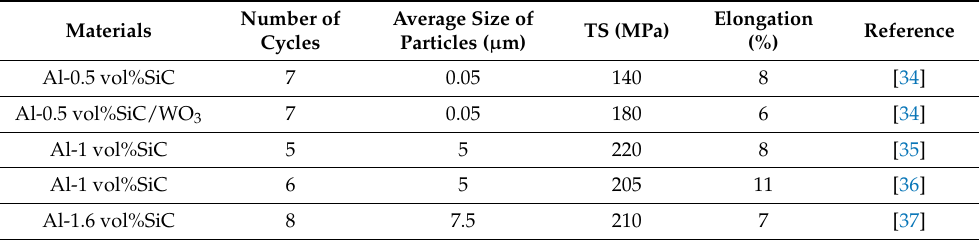
Table 2. Summary of mechanical properties reported by similar